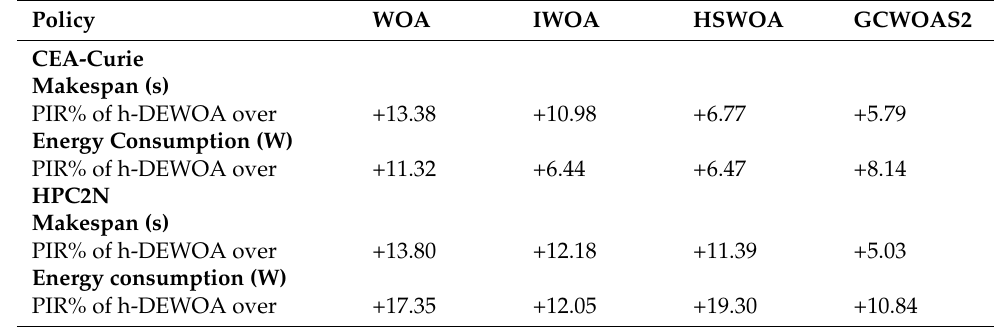
Table 11. PIR% of the h-DEWOA over other WOA-based scheduling